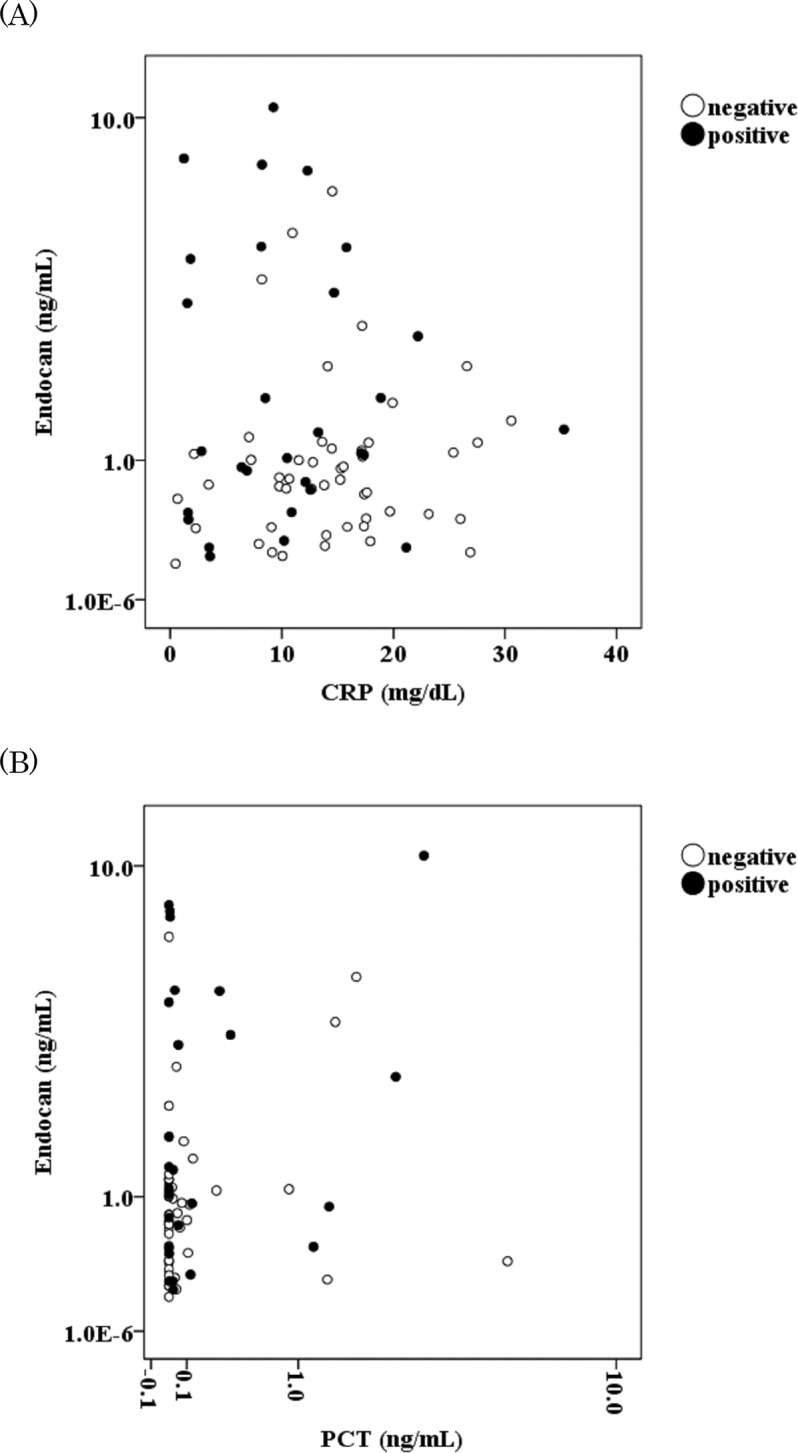
Correlations between the results for C-reactive protein (CRP) and endocan (A), and those for procalcitonin (PCT) and endocan (B).The black and white circles represent the levels of the markers in the blood culture-positive (n = 29) and-negative (n = 49) groups, respectively. The y axes for endocan in (A) and (B), and the x axis for PCT in (B) are in log values.